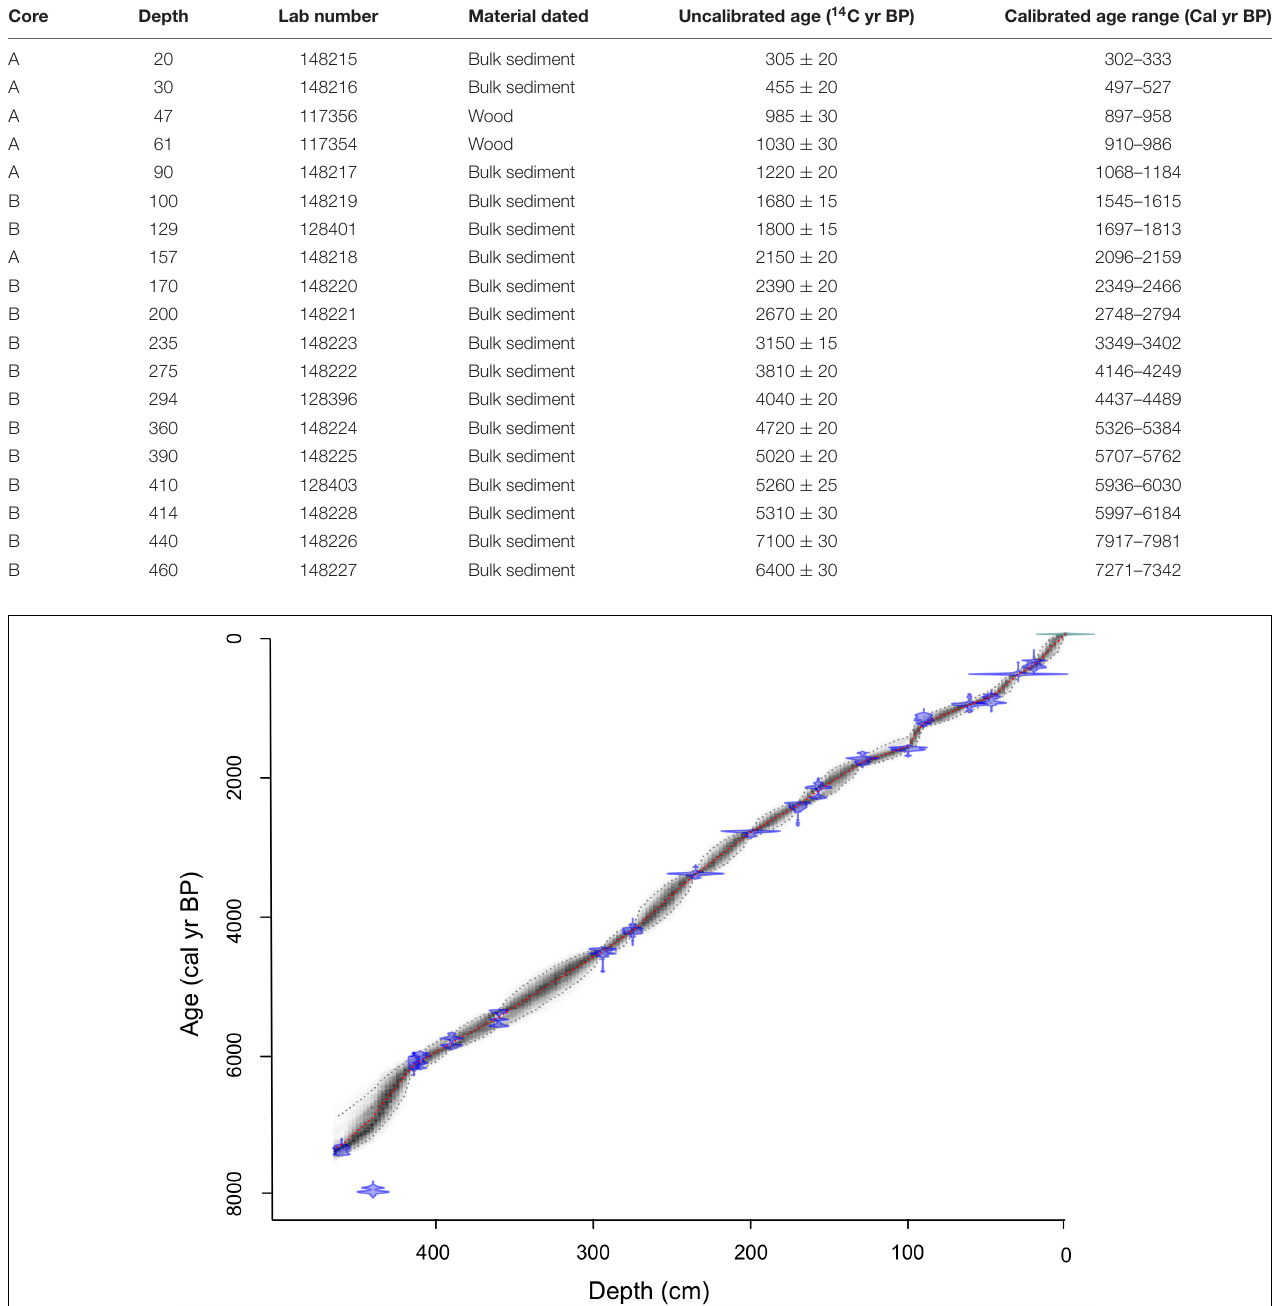
TABLE 1 | Material dated and radiocarbon ages for Black Lake.